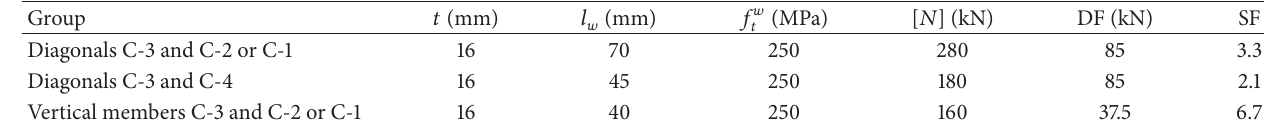
Table 4: Size and bearing capacity of the butt weld.